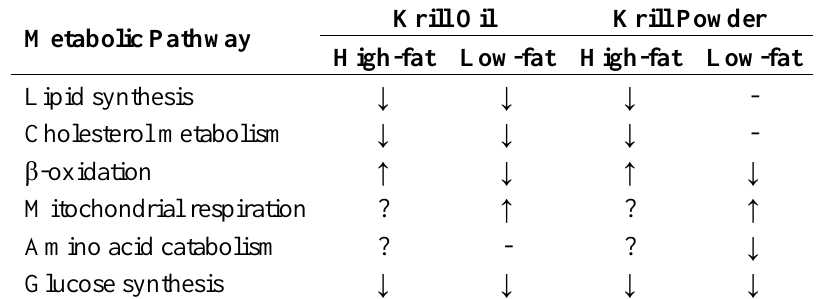
Table 3. Metabolic changes in mice receiving either a low or high fat diet with inclusion of krill oil or krill powder (summary from [26,37,38]). Adapted with permission from